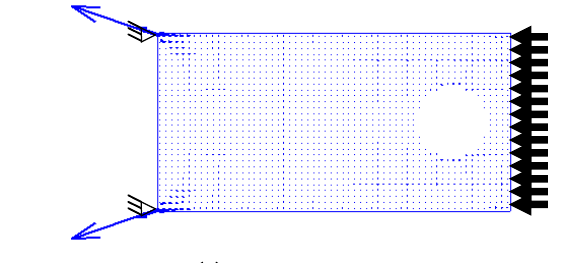
Similar to the case with no hole, distributions transferred and potential transferred force show elements next to the supports transfer the most load (Fig 27 (a)). Strengthening these regions consistently improv stiffness and load transfer (Figure 27 (b)). The differen between the case with hole and no hole are subtle. Th because the hole is in the region where the contributions elements in transferring loads are minimal. Thus removi elements to create the hole does not significantly chan overall load transferred by the other elements. Figure 27 and (d) present orientations of transferred and potent transferred force as unit vectors. Both figures visualize t flow of fo cture arce being transferred across the stru hole. Based on the orientations, no can be traced to connect loading point and reaction poi Also, the information obtained does not indicate regi with high stresses. Using the magnitude of the transfer and potential transferred force enables stiffness tailoring the structure by removing material from regions with l transferred and potential transferred